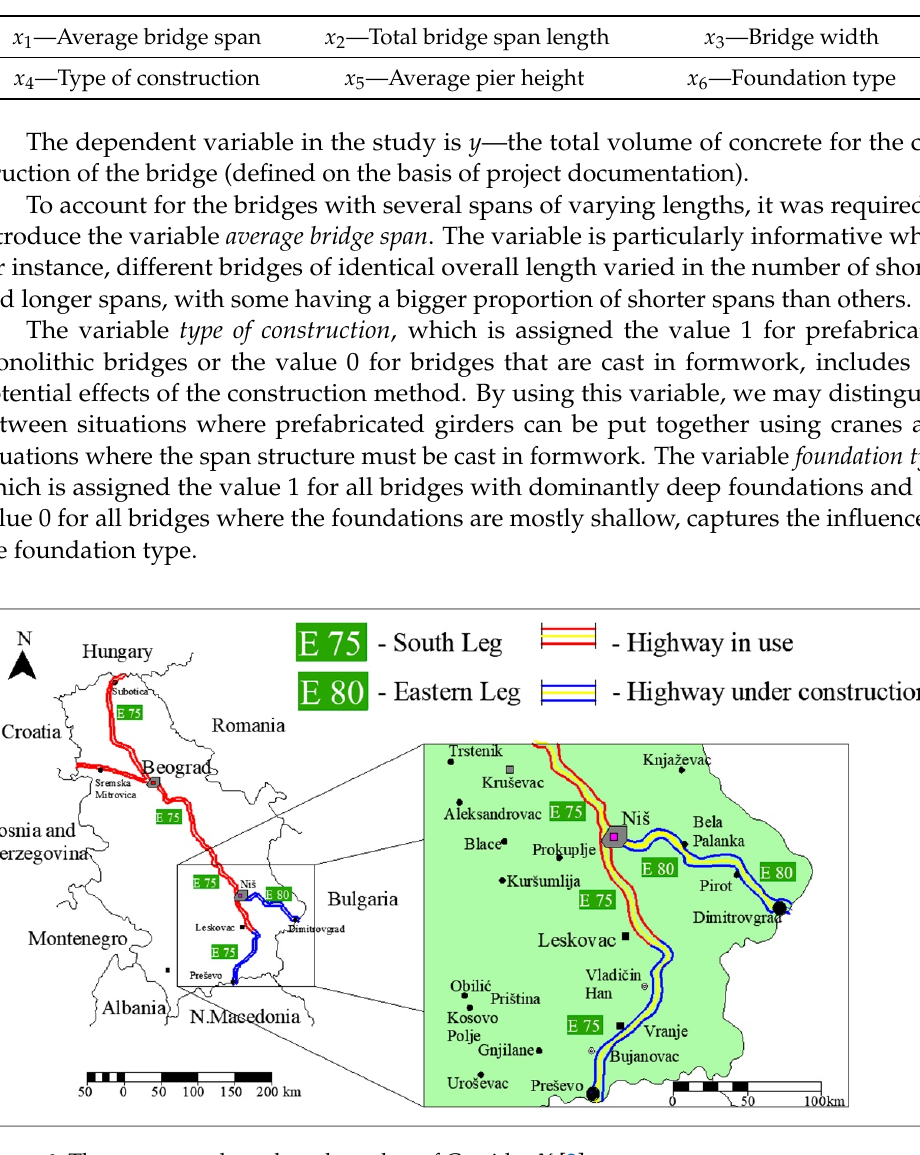
Figure 6. The eastern and southern branches of Corridor X [2].